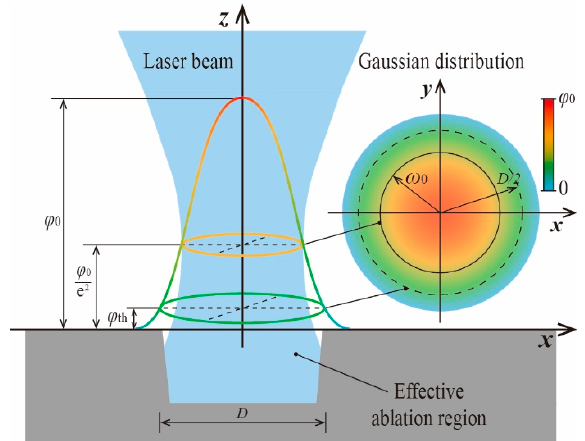
Figure 14. Schematic diagram of femtosecond laser energy distribution. The threshold of the target is equivalent to the laser fluence distributed at the border of the effective ablation region.